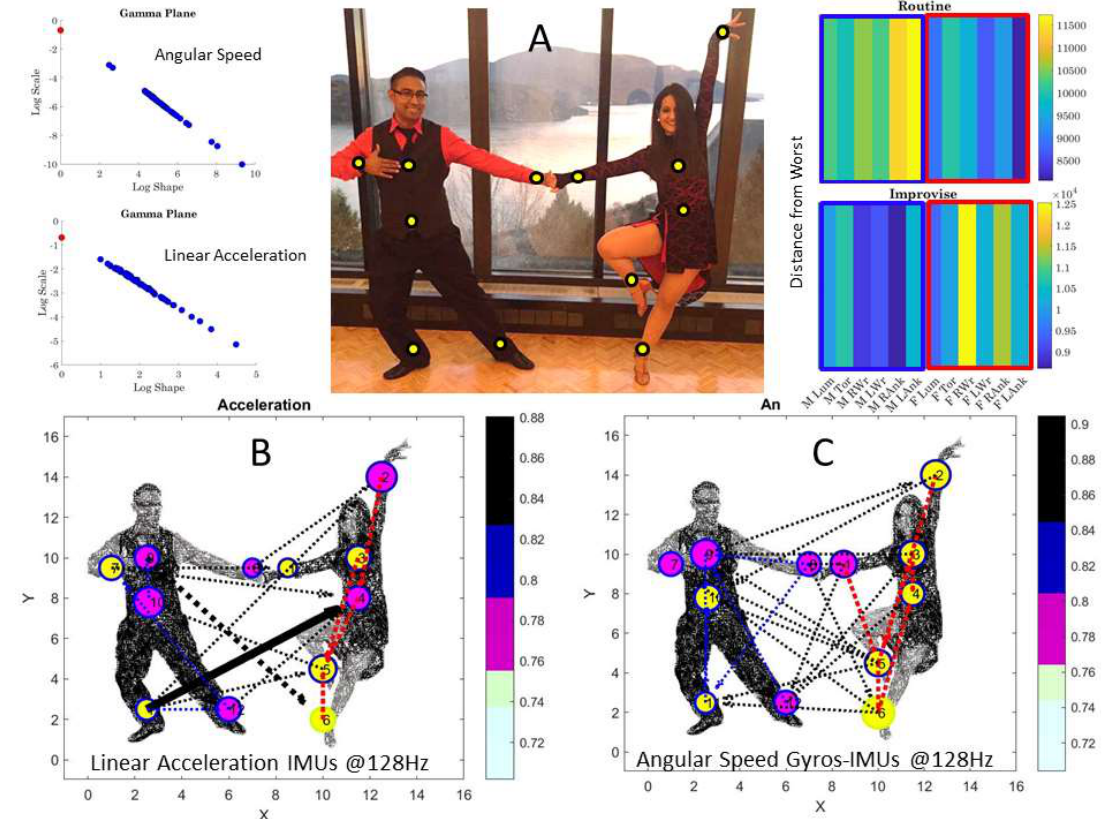
Figure A2. Network connectivity analyses of salsa dancing using a grid of IMUs of a commercially available sampling resolution. ( A ) Dancers in pose with sensors’ placement. ( B ) Network state derived from 30 s worth of data (30 × 60 × 128 frames at 128 Hz sampling resolution) with similar representation as Figure 7 in main paper. MM spikes derived from the fluctuations in linear acceleration amplitude. Linear acceleration time-series obtained from triaxial acceleration using the Euclidean norm to compute the scalar acceleration amplitude. Node at locations represent two self-emerging modules (colored in magenta an d yellow). Circle size represents the strength of the connectivity (incoming and outgoing weighted directed links from the node). Circle edge represents the maximal cross-coherence value measured pairwise with the connecting node. Pairwise links between nodes represent node i leading node j ( i → j ) and thickness represents the phase shift (lower values are thinner dashed lines 0–60, 61–120, and higher values 121–180 are thicker continuous lines). Link colors represent inner connections (red female, blue male) and black links represent inter connections from coupled nodes. ( C ) Similar representation as in ( B ) using orientation data. Data comes from the angular speed derived from quaternions representing the rotations of gyroscopes. Insets above B localize the signatures on the Gamma parameter plane relative to the worst case scenario of exponential distribution shape = 1 with the highest possible noise (extracted from the session) for angular speed and linear acceleration. Corresponding distances from each point to the extreme (most random and noisiest) case are expressed as color-coded vectors above panel ( C ). Notice the complementary patterns between the well-rehearsed routine (male body leads and has strongest predictive signal vs. spontaneous improvisation whereby female leads with a stronger predictive signal than male).